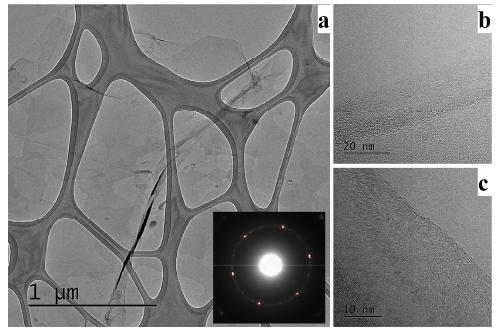
Figure 4. ( a ) TEM image of large area and continuous coal derived graphene film; Inset: SAED with six diffraction spots demonstrating the crystalline nature of the coal derived graphene film. ( b , c ) High magnification TEM image with the edge of the coal derived graphene film exhibiting bi ‐ layers to few layers of the film.